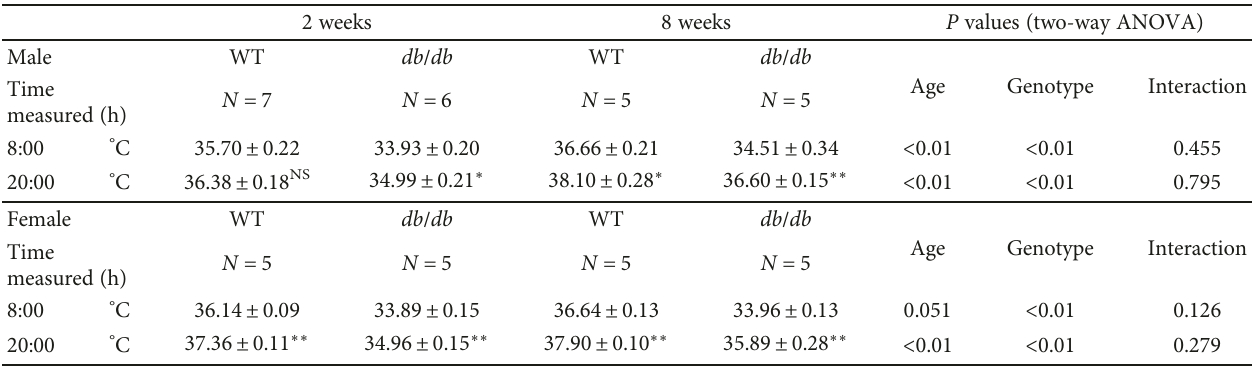
Table 3: Core body temperature in light and dark phases at 2 and 8